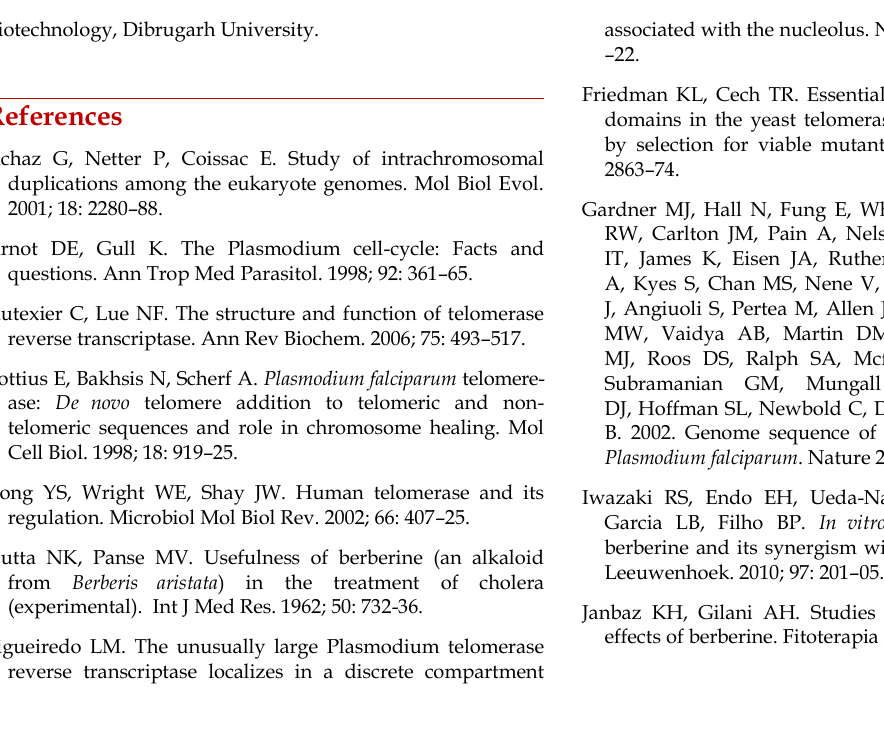
Figure 2: The interactions of the berberine betaine (A), berberine (B), coptisine (C), cyanodihydroberine (D), dihydroberbeine (E), methoxyhydroberberine (F), oxycanthine (G), palmitine (H), and 9,10-dimethoxy-5,8-dihydro-6H-[1,3]dioxolo[4,5-g] isoquino[3,2- a] isoquinoline (I) against the proteins. The colors below were represented as the interacting hydrogen bonds between the protein and the drugs